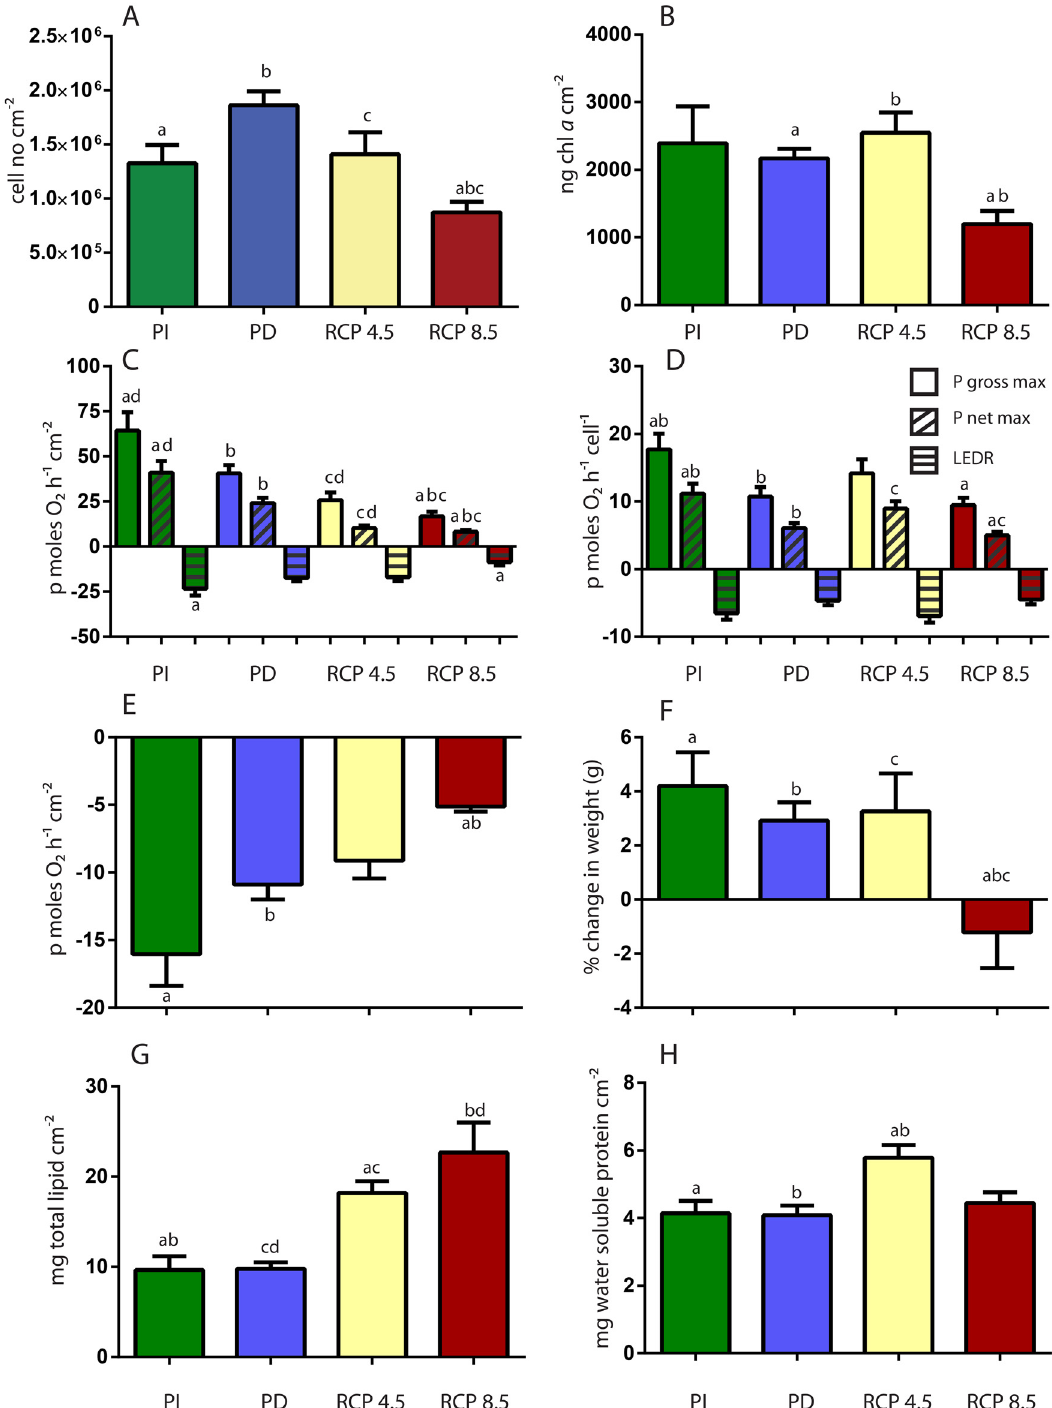
Fig 1. The effect of past and future changes in seawater temperature and pCO 2 (Pre Industrial, PI, Present Day, PD, Representative Concentration Pathway RCP4.5 and RCP8.5) conditions on coral-algal physiology. (A) Symbiodinium cell number (B) chlorophyll a levels per surface area (C) photosynthetic capacity per surface area measured as P net max, light enhanced dark respiration(LEDR) and P gross max (P net max — LEDR) (D) photosynthetic capacity per symbiont cell measured as P net max, light enhanced dark respiration(LEDR) and P gross max (P net max — LEDR) (E) dark respiration (R dark ) (F) relative calcification/growth as % change in weight (G) total lipid content and (H) total water soluble protein content. Error bars represent the standard error of the mean (n = 16). Post hoc differences are provided above the relevant data in letter symbols.